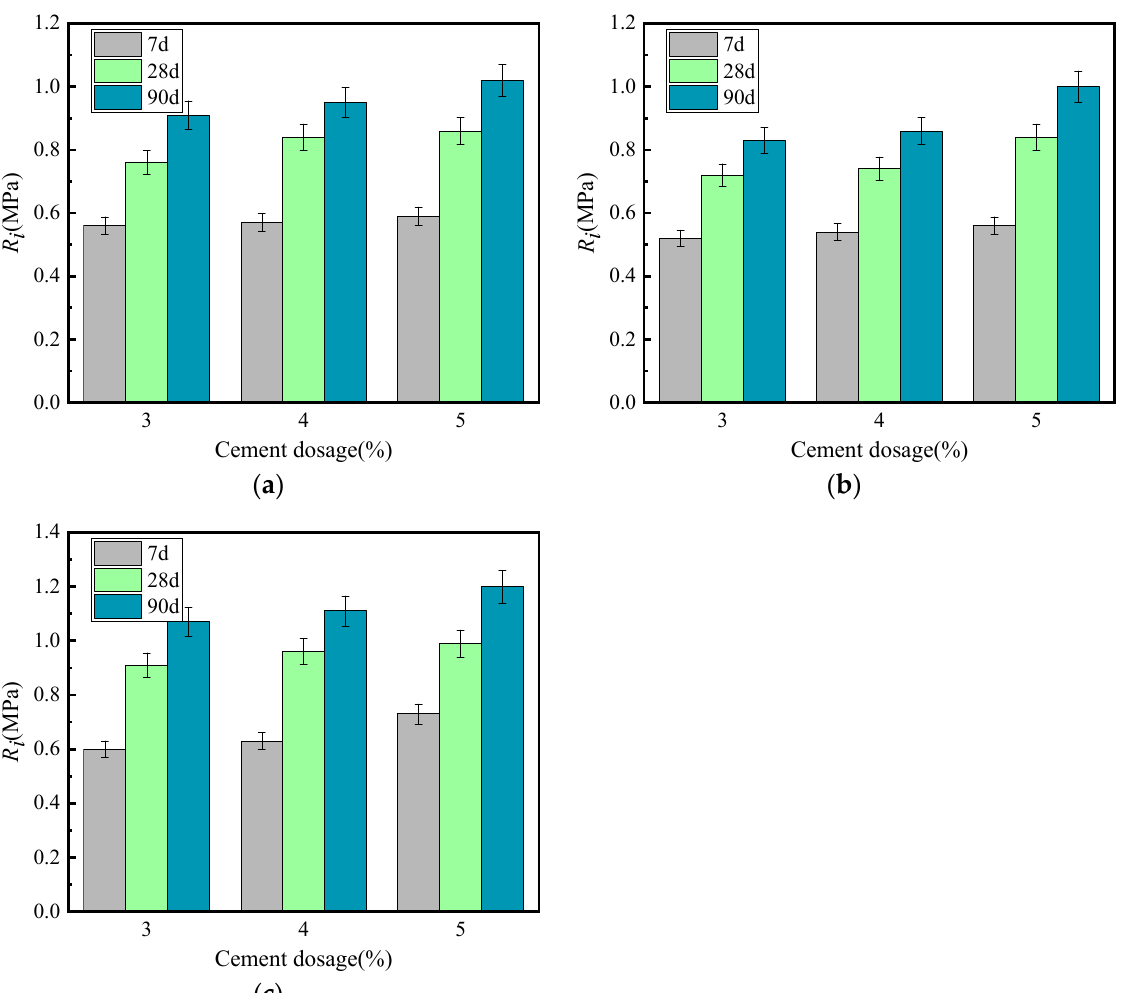
Figure 6. Growth law of splitting strength under different cement dosages. ( a ) GF1, ( b ) GF2, ( c ) VGM-30.